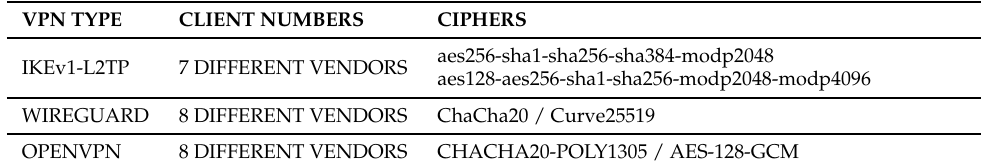
Table 7. VPN algorithms which provide the best compatibility with the current